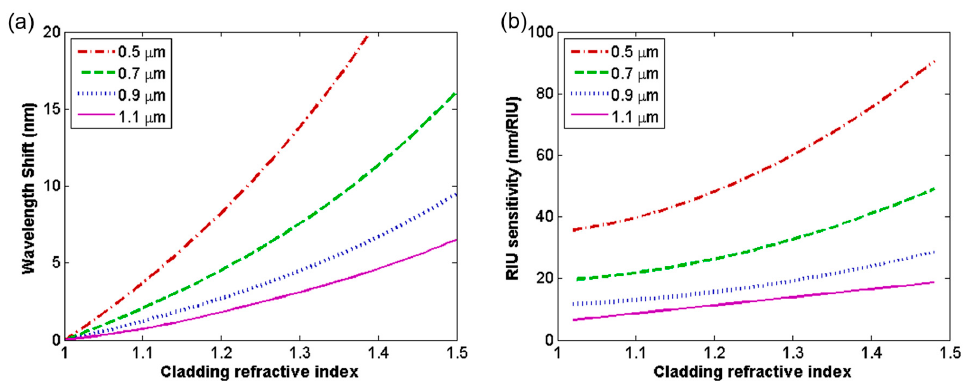
8 of 12 Figure 7. Cavity resonance modes around 1600 nm measured in air (fit with red line) and after coating the chip in water (fit with blue line) for (a) 900-nm-thick and (b) 1100-nm-thick TeO 2 resonators, demonstrating resonance broadening in water. Figure 8a shows the predicted wavelength shift for different cladding refractive indices calculated for different TeO 2 layer thicknesses at a wavelength of 1600 nm. Simulations for the 900-nm-thick TeO 2 device predicted a wavelength shift of 4.81 nm for a DI water cladding ( n cladding =1.316), which agreed well with the measured 4.81 nm shift. Likewise, the 1100-nm-thick TeO 2 device’s simulated 3.32 nm wavelength shift agreed well with the measured 3.34 nm shift. Based on this simulation, the 480-nm-thick TeO 2 device could have been expected to have a shift of approximately 14.8 nm if its resonances were not extinguished. It can also be seen from the figure that the wavelength shift versus cladding refractive index is not a linear relationship, with greater sensitivity as the cladding refractive index increases. This relationship is a result of the decreased refractive index contrast between the TeO 2 waveguide and the cladding at larger cladding refractive indices, causing the evanescent tail of the waveguide mode to leak more into the cladding. This effect becomes more pronounced in the TeO 2 microcavity than it would be in a silicon waveguide, where the refractive index of the silicon waveguide core is significantly larger than the cladding medium. This effect results in a discrepancy between the measured data based on Figure 5 and the